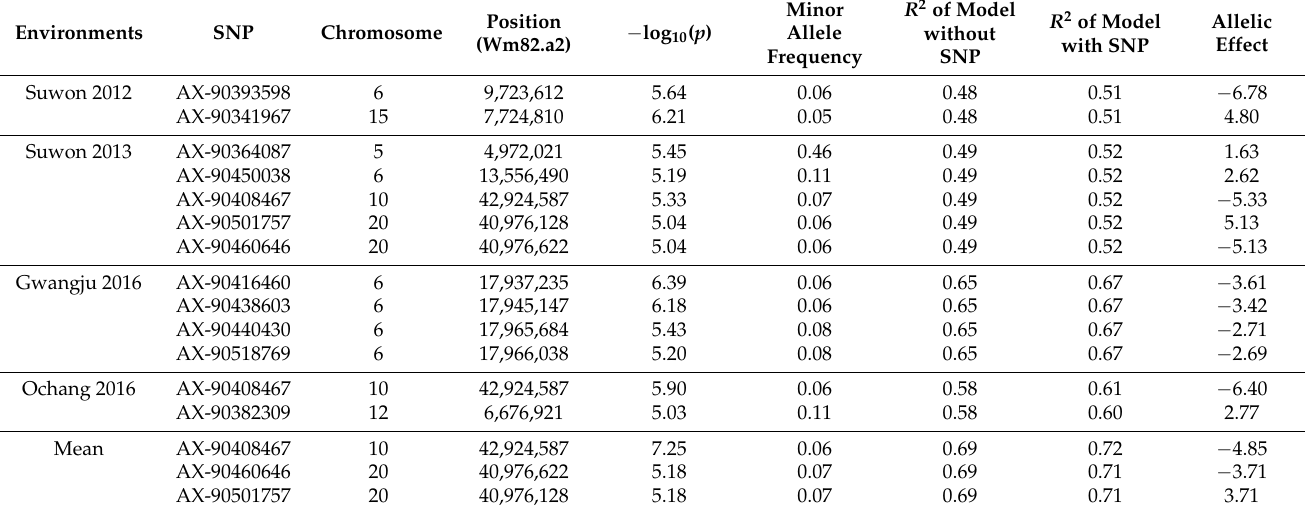
Table 1. SNP loci associated with days to flowering in five different environments.